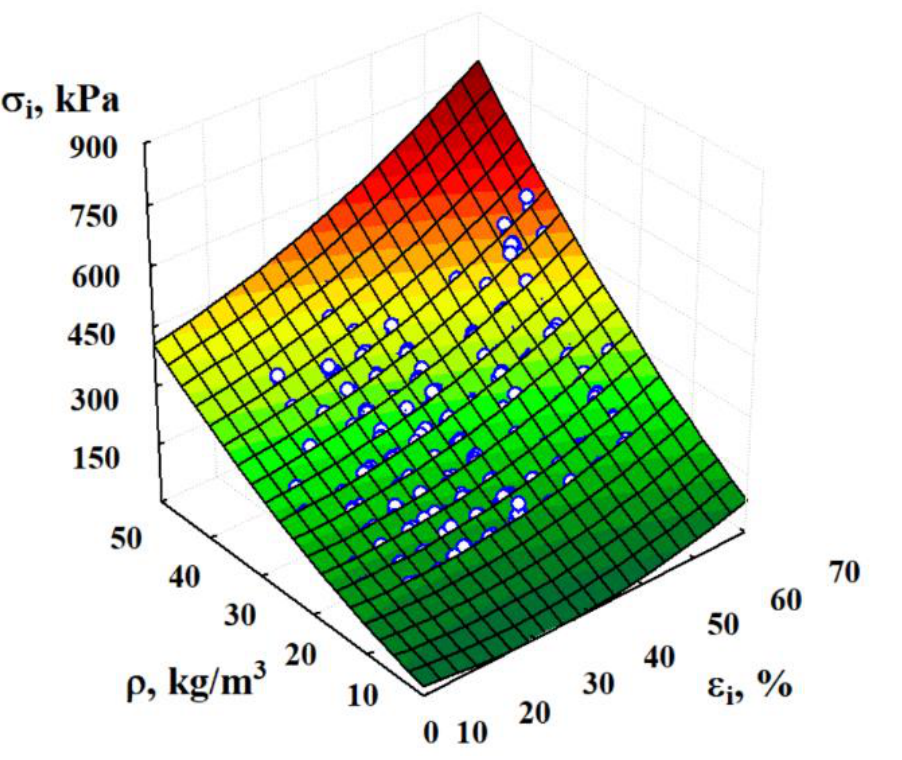
Figure 7. Graphical interpretation of the regression multinomial (8) characterizing the dependence of the stresses σ i on active elastic–plastic deformations ε i